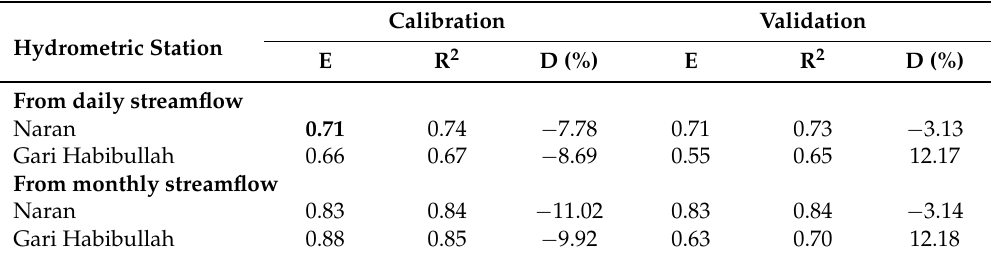
Table 3. Nash-Sutcliffe efficiency (E), coefficient of determination (R 2 ), and percent deviation (D) for calibration (1982–1989) and validation (1978–1981) for different stream gauges, calculated from daily and monthly data, in the Kunhar River